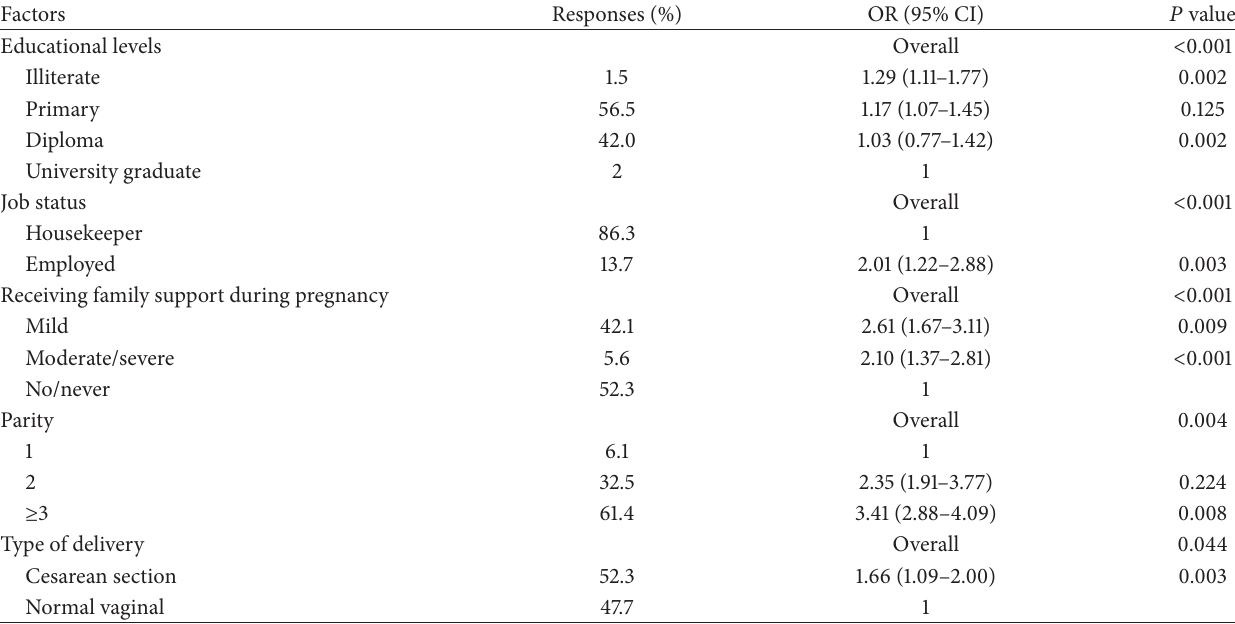
Table 4: Adjusted odds ratios (ORs) from the multiple logistic regression analysis of postpartum depression risk factor.